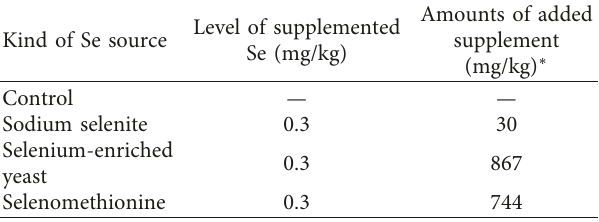
Table 2: Scheme of selenium